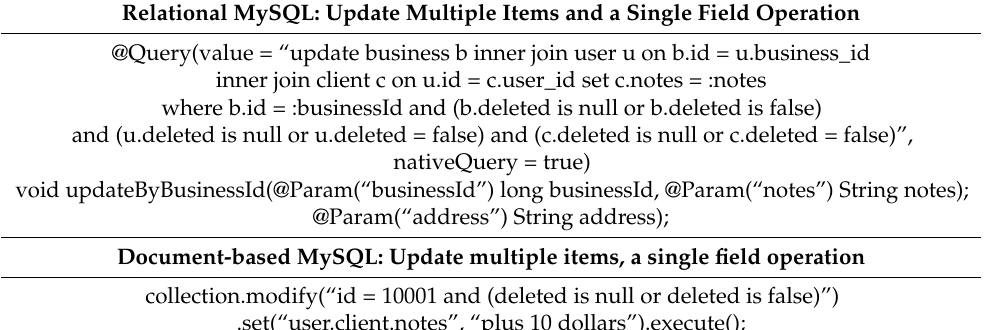
Table 6. Update multiple items and a single field operation.